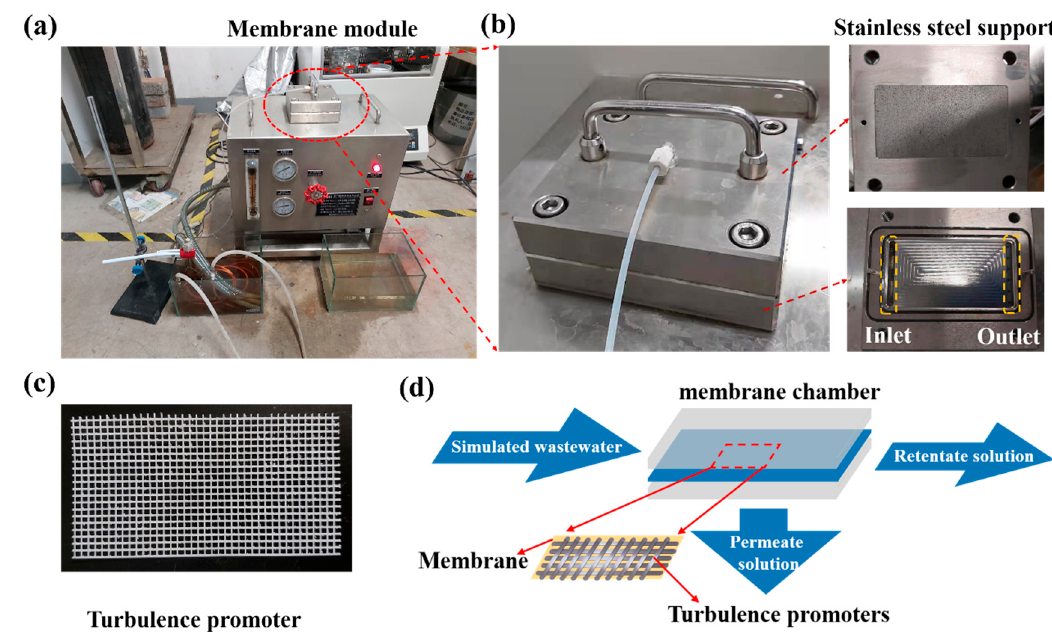
Figure 2. Photographs of ( a ) the crossflow membrane filtration equipment, ( b ) flat-sheet membrane chamber (composed of stainless steel support, inlet, and outlet), and ( c ) turbulence promoter, and ( d ) schematic diagram of the interior components of the membrane chamber.